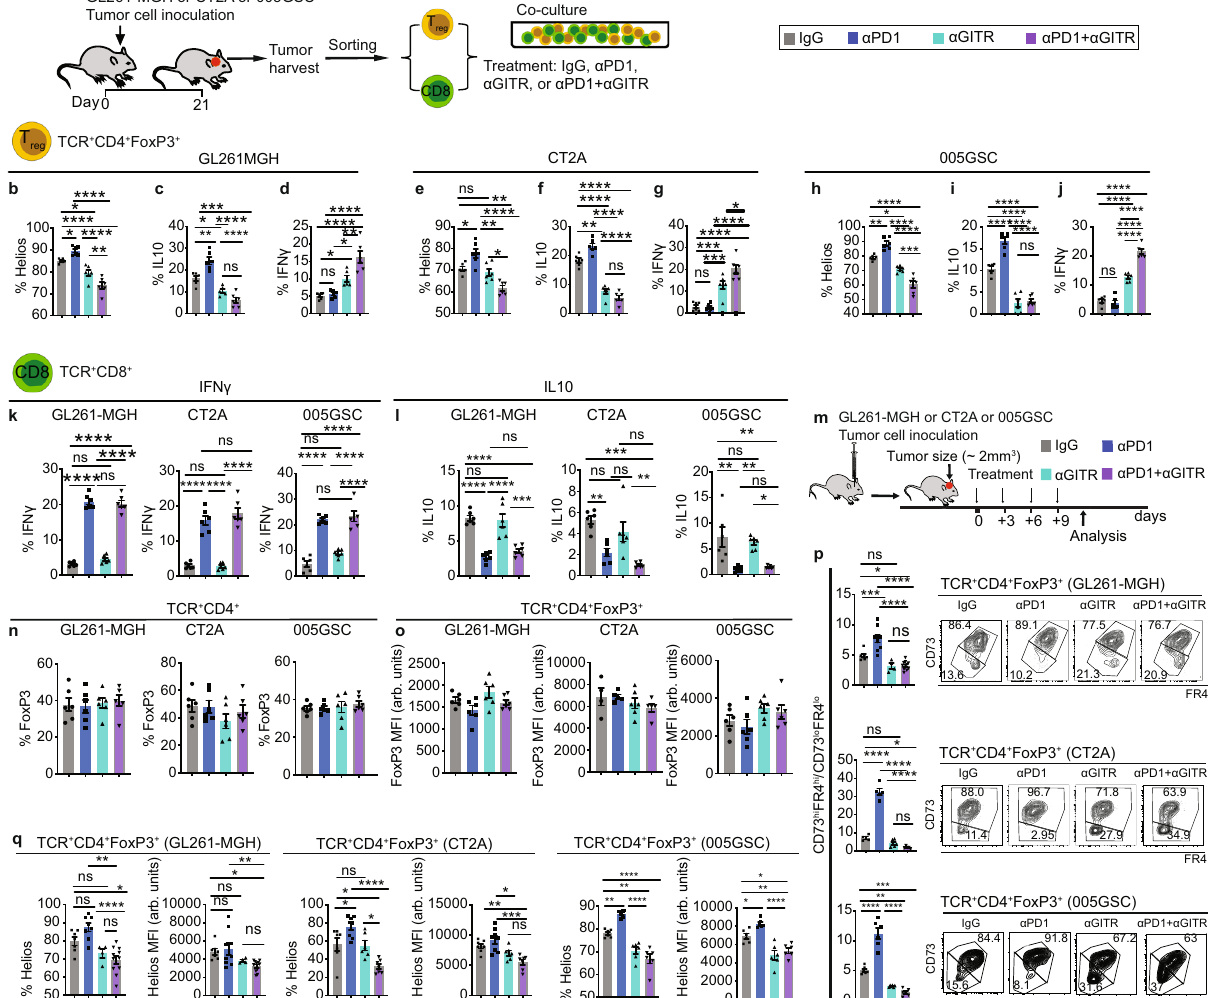
Fig. 2 Engagement of GITR with an agonistic antibody ( α GITR) converts Treg cells to CD4 T effector cells. a Schematic representation of the ex vivo treatment experiments of Treg cells and CD8 T cells derived from tumor-bearing mice. Tumors [GL261-MGH ( n = 24), CT2A ( n = 25), 005GSC ( n = 20)] were inoculated and harvested 21 days post-inoculation. Treg cells and CD8 T cells were sorted using FACS. CD8 T cells (2 × 10 3 ) were co-cultured with Treg cells (2 × 10 3 ), accompanied by treatment with (i) IgG2a (isotype control), (ii) α PD1, (iii) α GITR, or (iv) α GITR + α PD1 ( n = 6 per treatment, 1 treatment, 20 µ g/mL for each antibody). b – j Treg cells (day 4) were analyzed for expression of Helios ( b , e , h ), and cytokines IL10 ( c , f , i ) and IFN γ ( d , g , j ). ( n = 6 biological replicates for each treatment), Data presented are mean ± SEM. P < 0.0001 by ordinary one-way ANOVA test and were corrected for multiple comparisons using the Tukey adjustment for ( b – j ). Stars were assigned as * p < 0.05, ** p < 0.01, *** p < 0.001, **** p < 0.0001. k , l CD8 T cells were analyzed for the production of cytokines IFN γ (K) and IL10 (L) ( n = 6 biological replicates for each treatment). Data presented are mean ± SEM. P < 0.0001 by ordinary one-way ANOVA test and were corrected for multiple comparisons using the Tukey adjustment ( k & l ). Stars were assigned as * p < 0.05, ** p < 0.01, *** p < 0.001, **** p < 0.0001. m Schematic representation of experimental protocol. Mice bearing orthotopic GBM tumors (GL261-MGH, CT2A or 005GSC, size ~2 mm 3 ) were treated with 4 doses of: (i) IgG2a, (ii) α PD1, (iii) α GITR, or (iv) α GITR + α PD1 (250 µ g/mice). n – o Intratumoral T cells were analyzed for Treg cell frequency ( n ) and FoxP3 MFI ( o ). Data presented are mean ± SEM. P > 0.05 by ordinary one-way ANOVA test. Treg frequency data ( n ), was a collection of 6 biological replicates per treatment arm. MFI of FoxP3 ( o ) n = 6 biological replicates across the tumor models and treatment arms excluding IgG treatment in CT2A ( n = 4 biological replicates), α PD1 ( n = 5 biological replicates) and α GITR ( n = 7 biological replicates). Data points are not signi fi cantly different from each other ( n – o ). p Intratumoral Treg cells were analyzed for the co-expression of CD73 and FR4. GL261-MGH (IgG n = 7, α PD1 n = 9, α GITR n = 4, α PD1 + α GITR n = 11), CT2A (IgG n = 4, α PD1 n = 5, α GITR n = 6, α PD1 + α GITR n = 5), 005GSC (IgG n = 6, α PD1 n = 6, α GITR n = 6, α PD1 + α GITR n = 6). Data presented are mean ± SEM. P < 0.0001 by ordinary one-way ANOVA test and were corrected for multiple comparisons using the Tukey adjustment. Stars were assigned as * p < 0.05, ** p < 0.01, *** p < 0.001, **** p < 0.0001. q Intratumoral Treg cells were analyzed for as